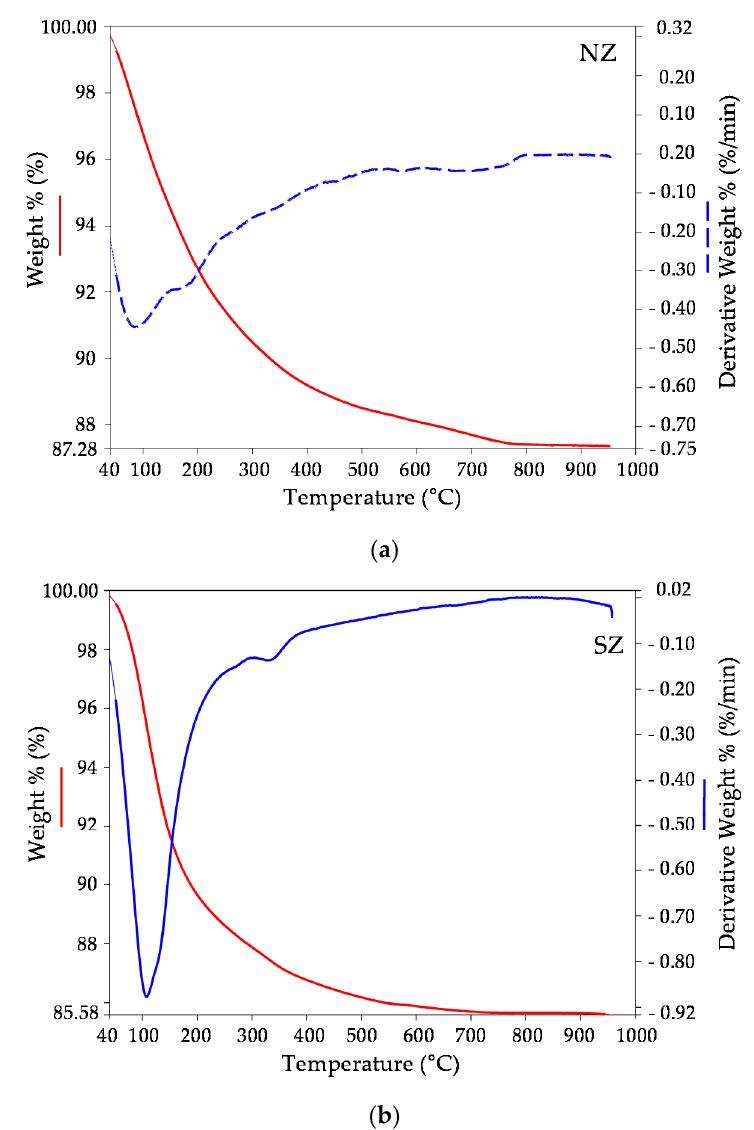
Figure 10. TG-DTG curves for ( a ) NZ and ( b ) SZ.